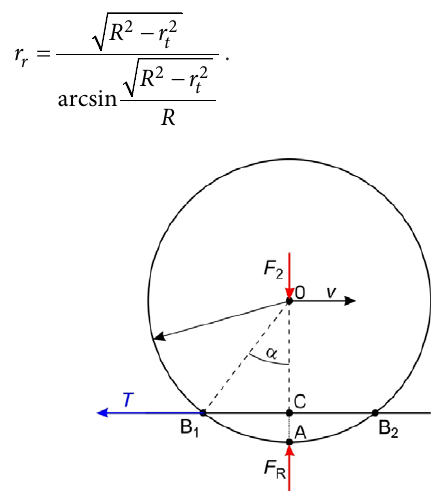
Figure 5. The geometrical parameters of the tyre in contact with ground